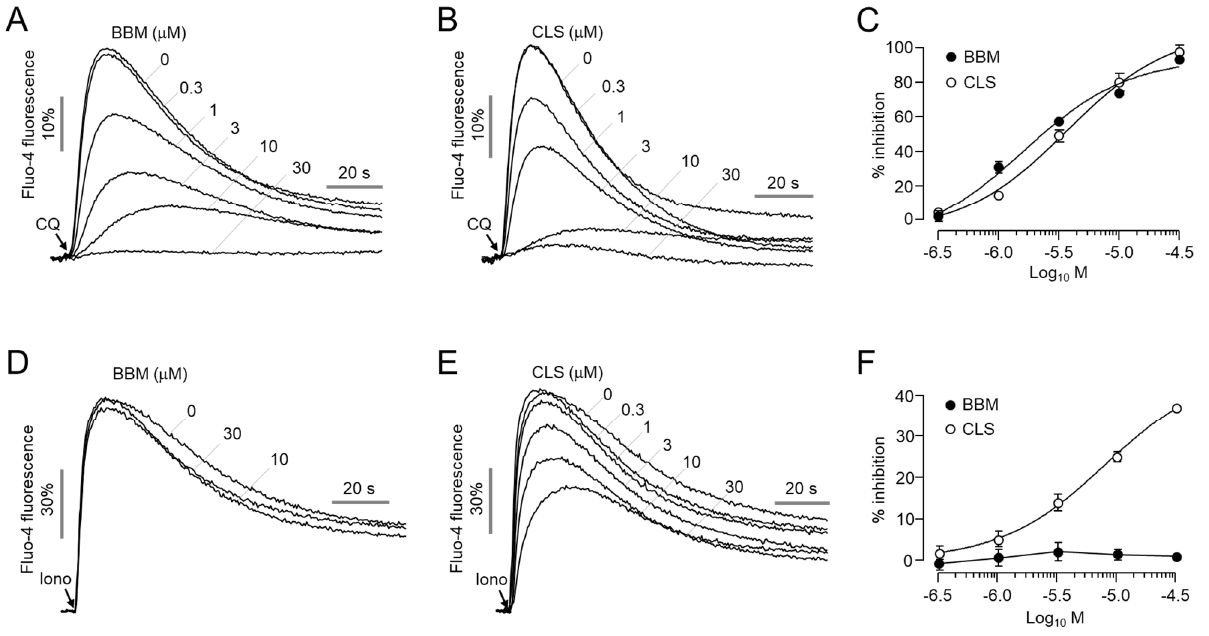
Figure 2. Effect of berbamine and closantel on CQ- and ionomycin-induced increases in intracellular calcium levels: ( A , B ) Intracellular calcium levels were measured using Fluo − 4 NW in HEK293T cells expressing MrgprX1. The cells were pretreated with the indicated concentrations of berbamine (BBM) and closantel (CLS) for 10 min prior to treatment with 300 µ M CQ. ( C ) Summary of dose-response (mean ± S.E., n = 6). ( D , E ) Intracellular calcium levels were increased with 10 µ M ionomycin in HEK239T cells. The cells were pretreated with the indicated concentrations of BBM and CLS for 10 min before treatment with ionomycin. ( F ) Summary of dose–response (mean ± S.E., n = 6).